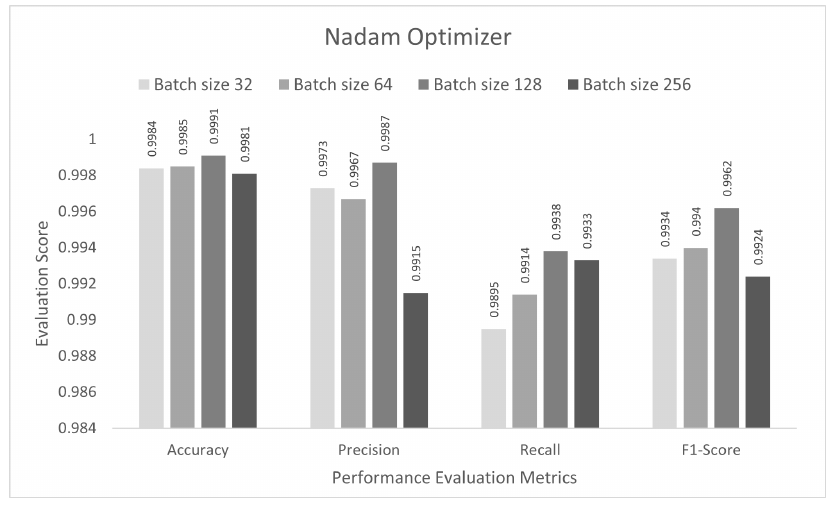
Figure 4. Nadam optimizer for binary class scenario.